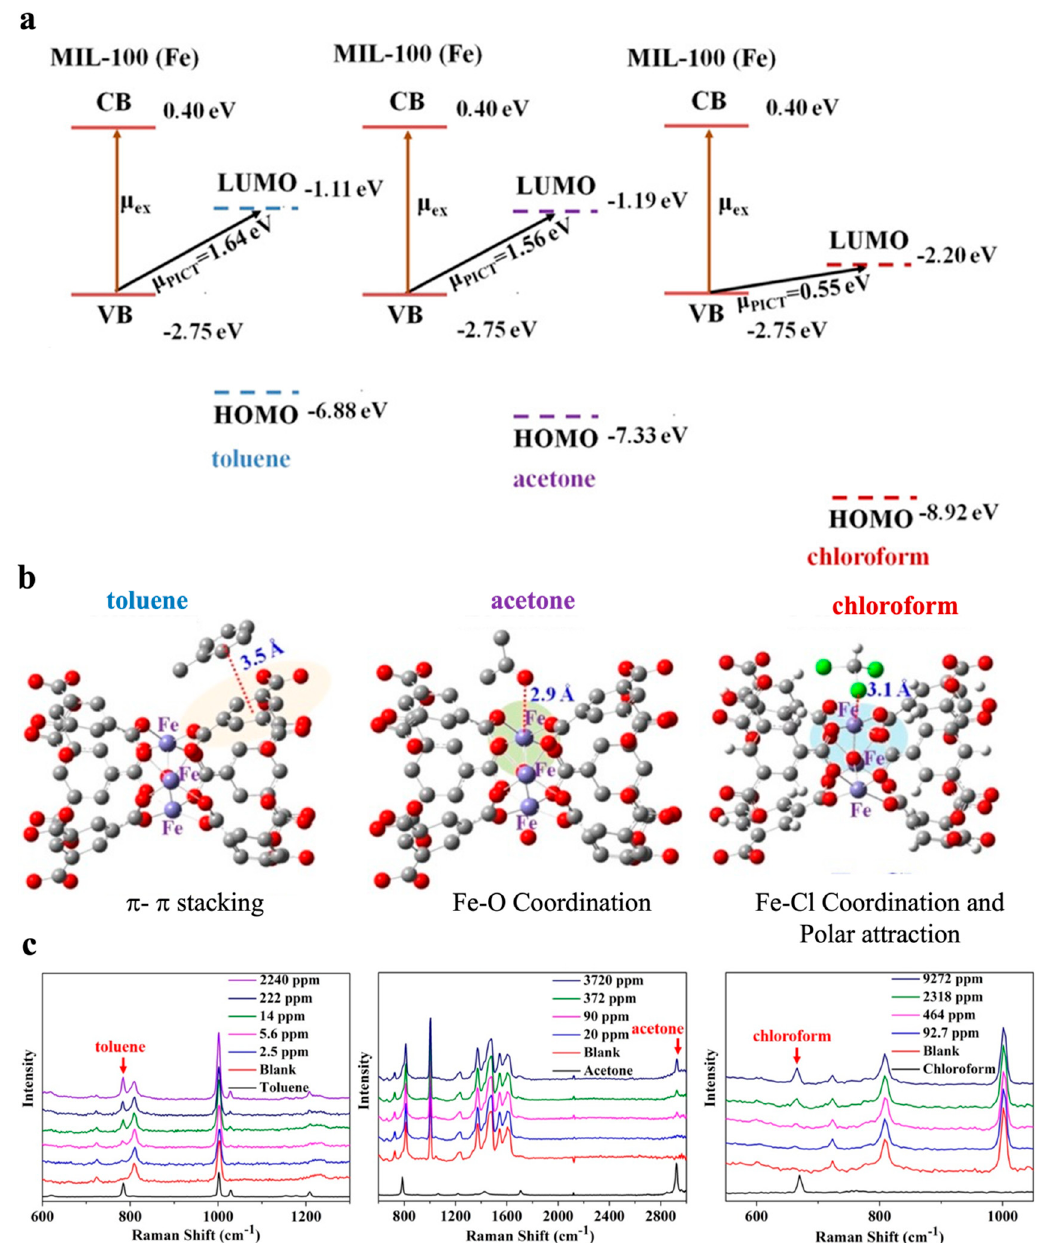
Figure 5. SERS of gaseous small molecules by MIL-100 (Fe). ( a ) Energy-level diagrams of toluene, acetone, and chloroform relative to MIL-100 (Fe) with respect to the vacuum level. ( b ) Adsorption affinity and binding energy of toluene, acetone, and chloroform on MIL-100(Fe). ( c ) SERS spectra of toluene, acetone, and chloroform vapor, respectively, on MIL-100(Fe), with concentrations as indicated [112]. Copyright 2020, John Wiley and Sons.